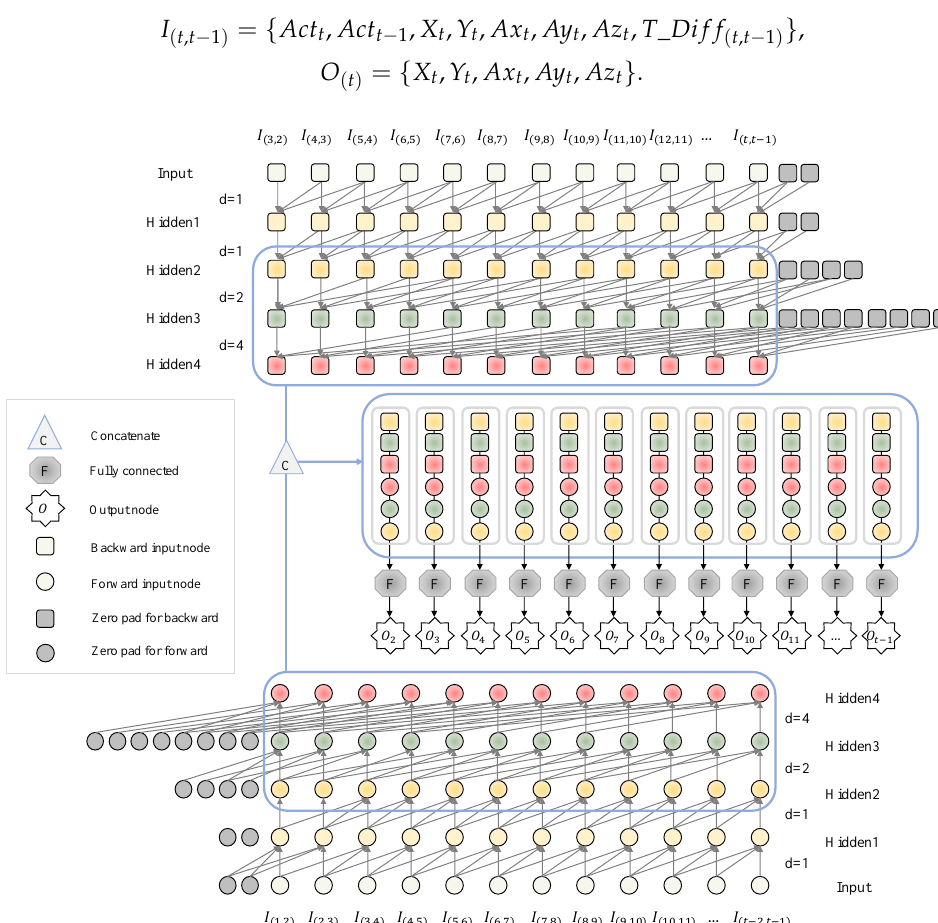
Figure 7. Proposed TCN-based DDP